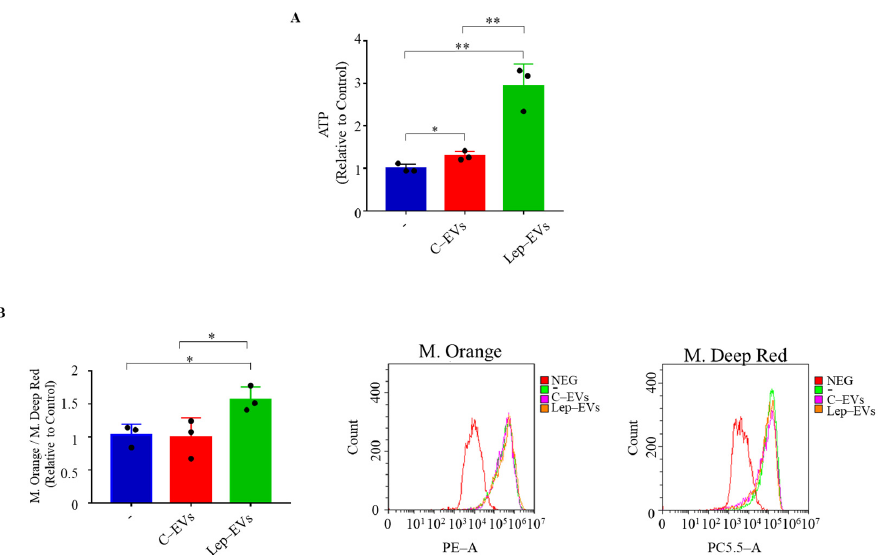
Figure 4. Effects of Lep-EVs on breast cancer cell energy production and on mitochondrial function. ( A ) ATP profiling production in MCF-7 breast cancer cells untreated (–) or treated with C-EVs and Lep-EVs (2 µ g/mL) for 48 h. ( B ) Mitochondrial membrane potential and mitochondrial mass were assessed using MitoTracker Orange CM-H2TMRos and MitoTracker Deep Red probes, respectively, in MCF-7 breast cancer cells untreated (–) or treated with C-EVs and Lep-EVs (2 µ g/mL) for 48 h. The ratio between mitochondrial membrane potential and mitochondrial mass and representative histograms of mean fluorescence intensity are reported. Each circle represents one independent experiment. Values are expressed as mean ± SD of three independent experiments each performed in triplicates. * p ≤ 0.05; ** p ≤